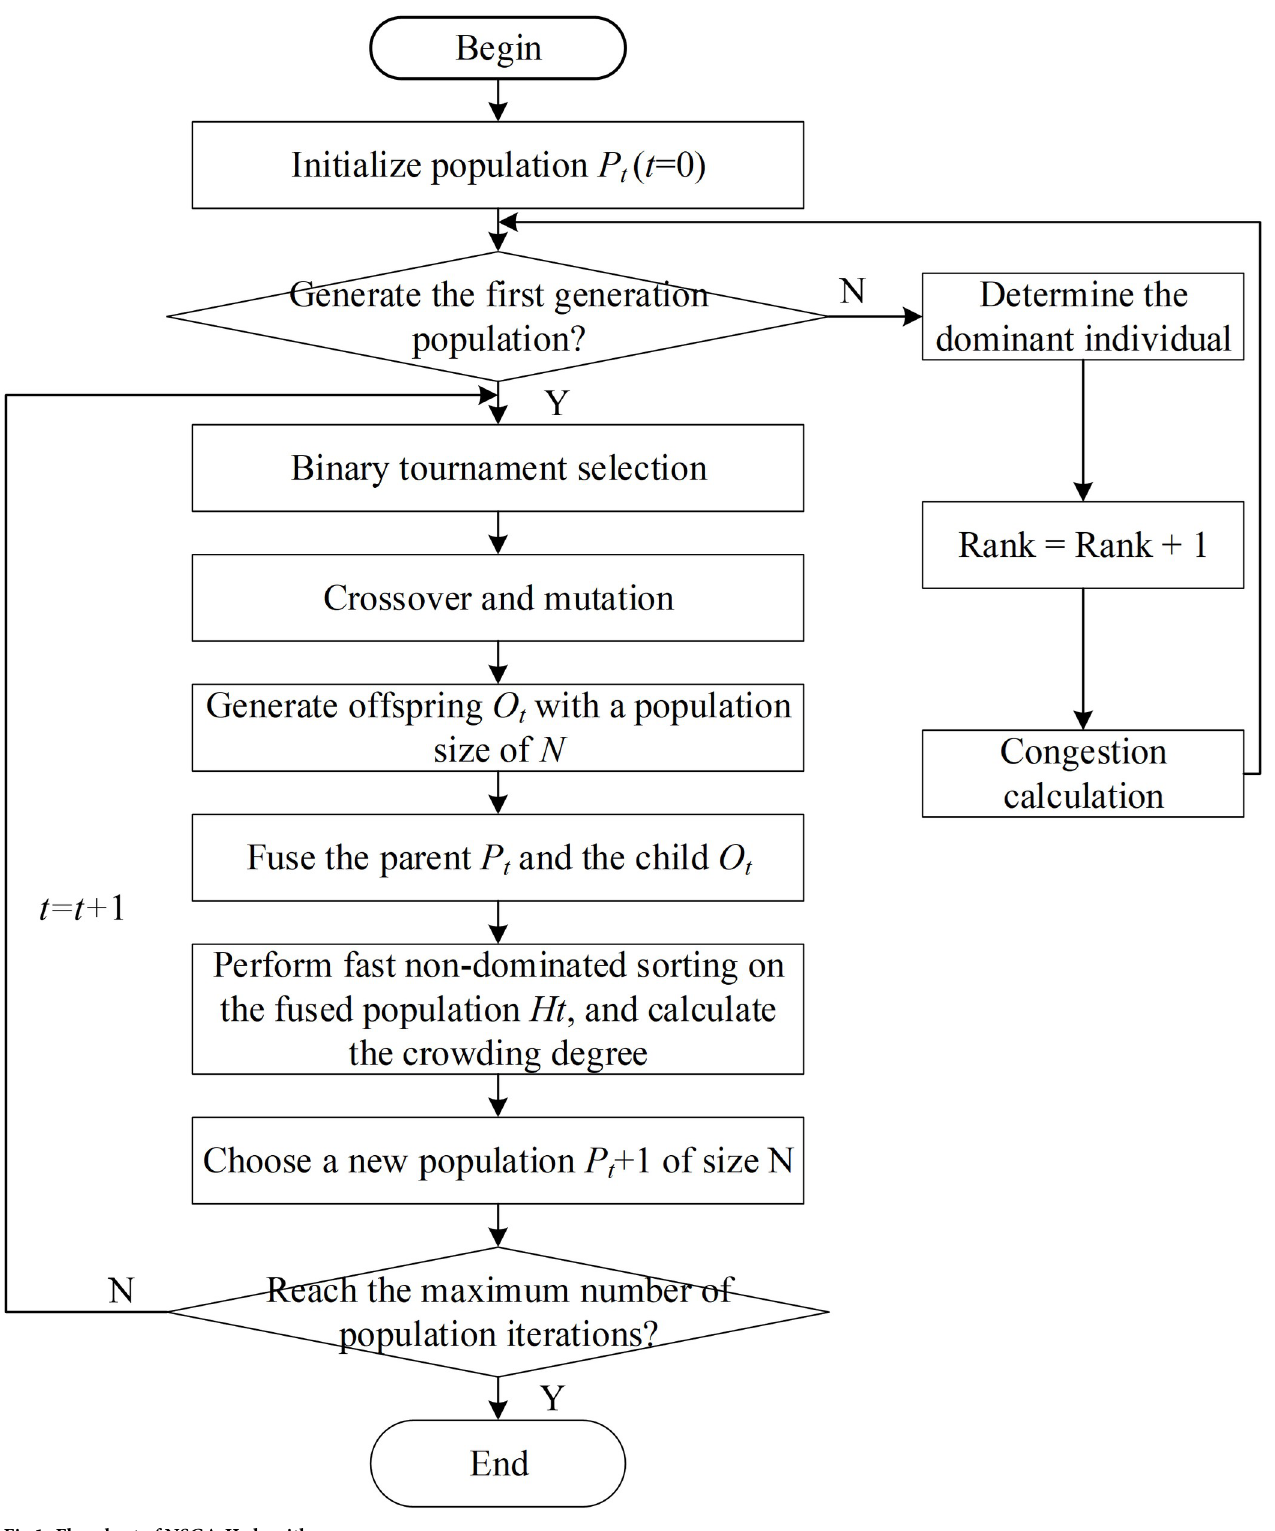
Fig 1. Flowchart of NSGA-II algorithm.